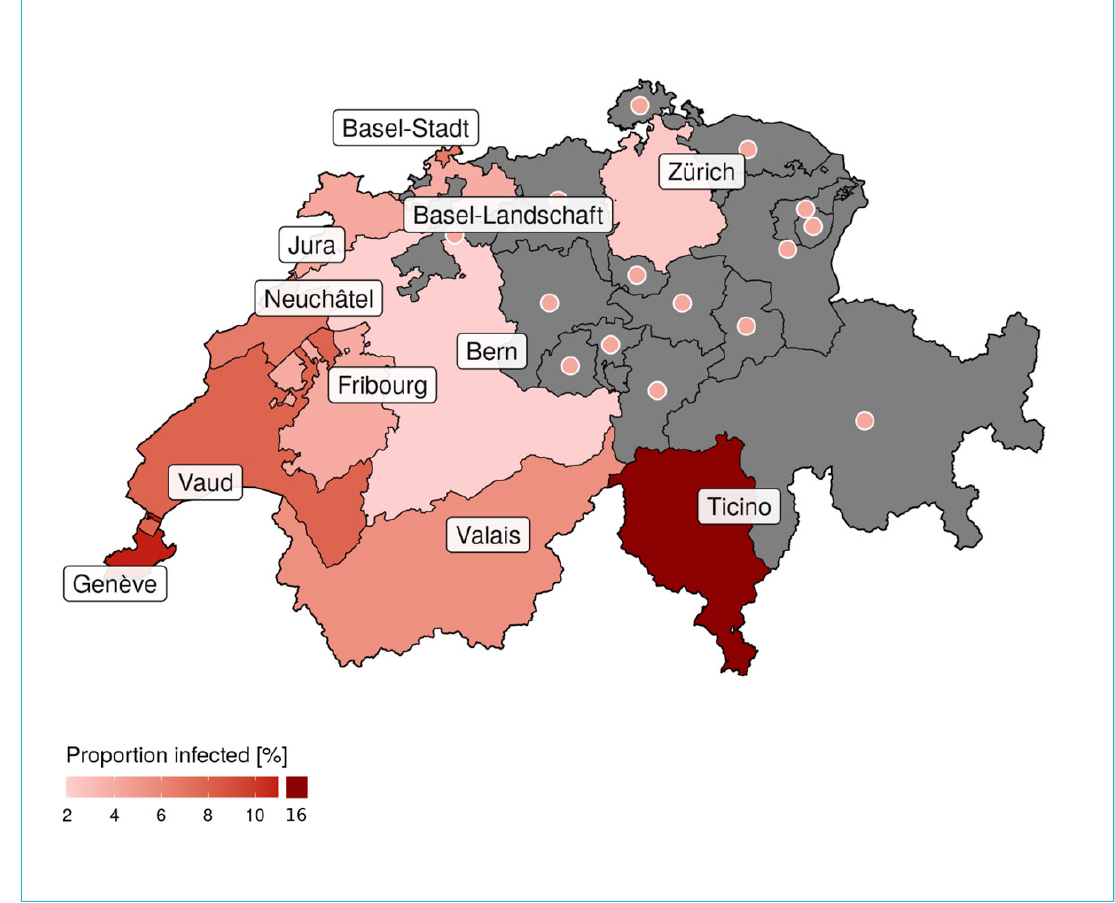
Figure 5: Modelled proportion of people infected with SARS-CoV-2 in Switzerland up to 24 April. Estimates were produced for 11 of 26 cantons for which enough data were available (unmodelled cantons are shown in gray with points indicating the national-level estimated inci- dence proportion of 3%). Values are reported in supplementarytable 6 of appendix